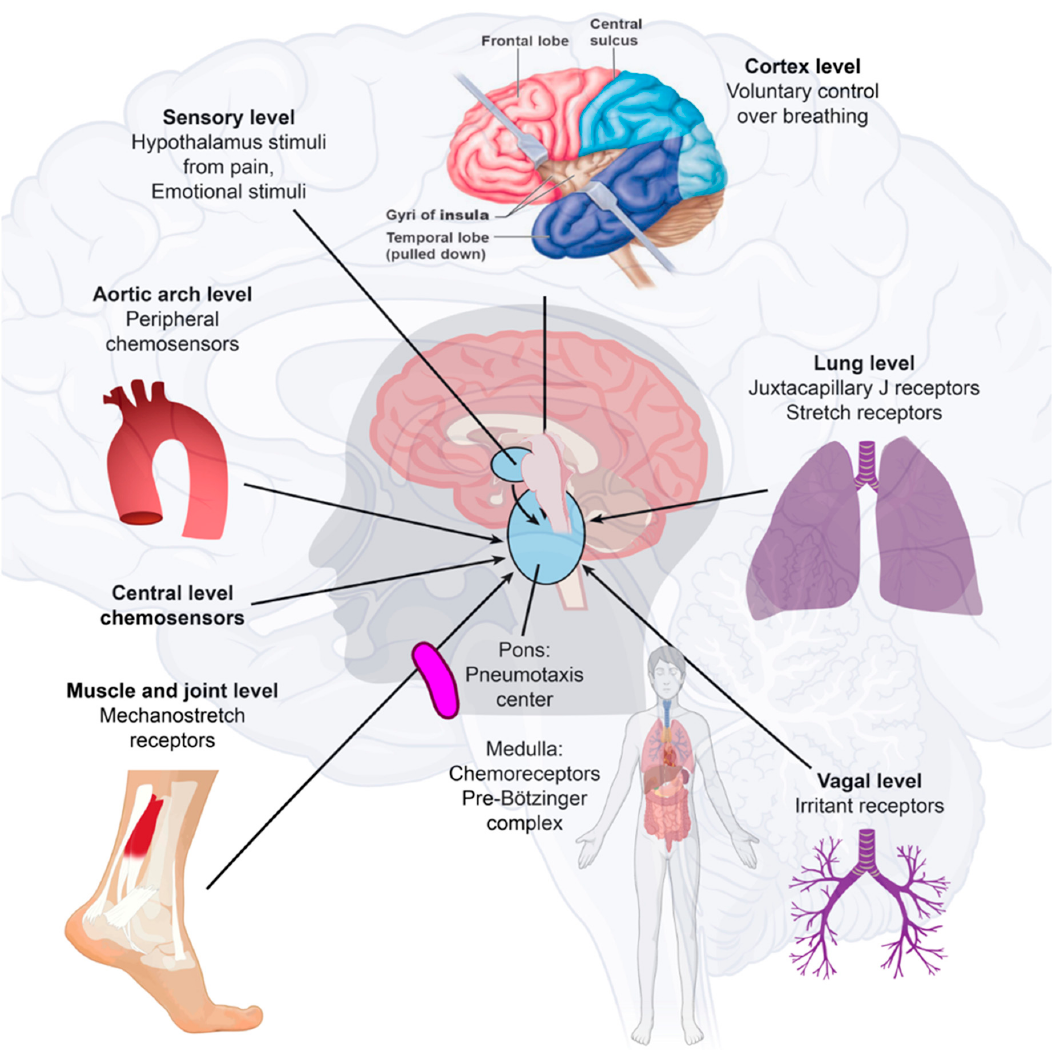
Figure 2. Immune-to-brain communication. The perivascular space contains a single or double layer of invaginated pia in the brain, forming an interstitial fluid-filled space representing an extension of the extracellular fluid space around the intracranial vessels as they move down into the brain parenchyma. Human sensory stimuli affect the breathing sensation passing through the cerebral cortex and hypothalamus. The respiratory muscles are not purposely activated in healthy breathing.